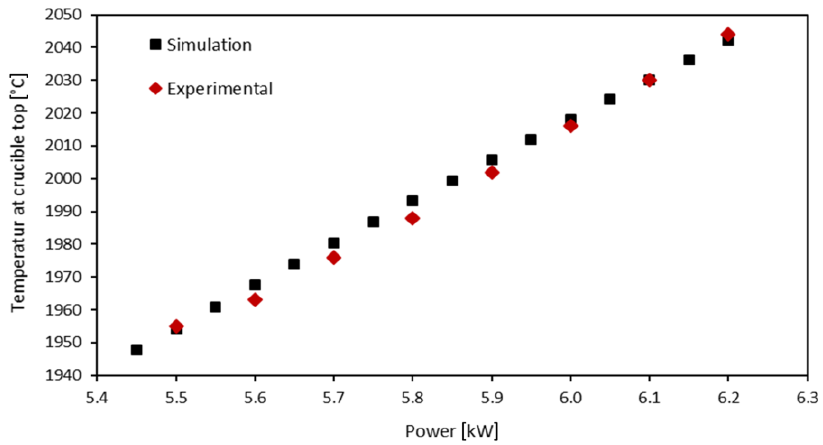
Figure 3. Comparison between measured temperatures at the crucible top during growth experiments in the 50 mm CS-PVT setup and simulated temperatures using COMSOL Multiphysics.